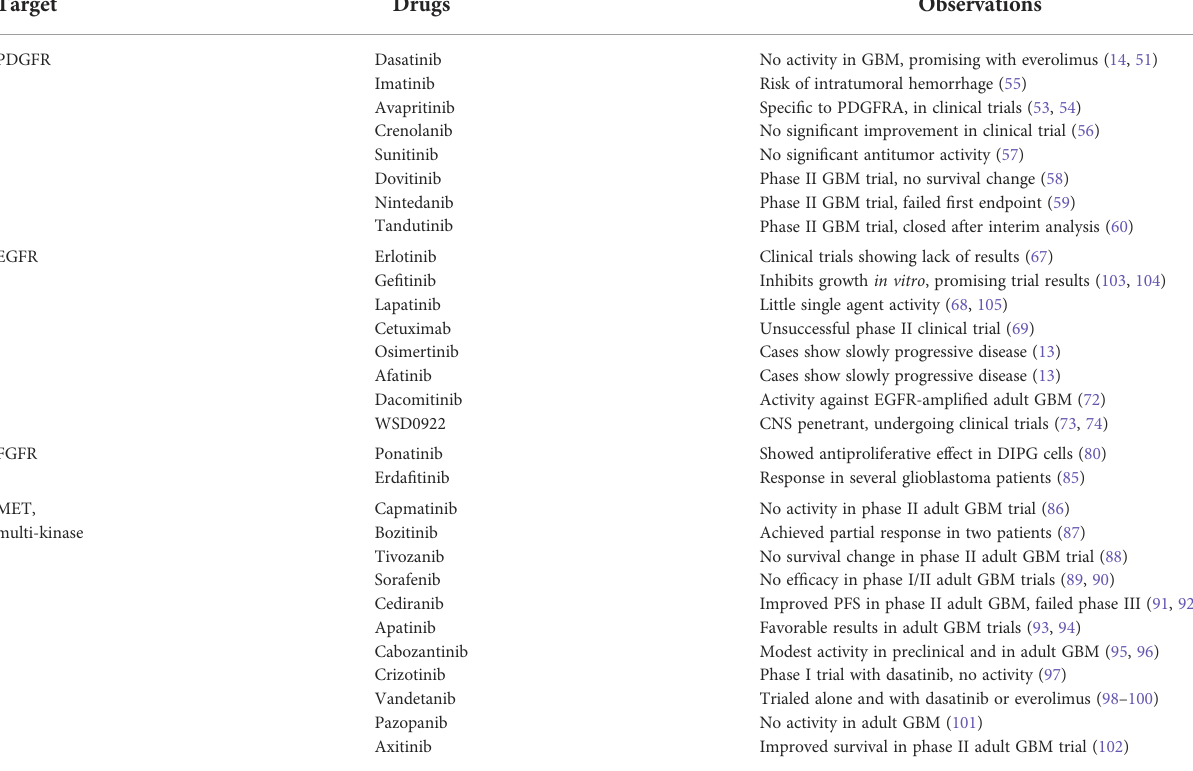
TABLE 1 Examples of RTK inhibitors used in preclinical or clinical therapies for pediatric high-grade glioma. Target